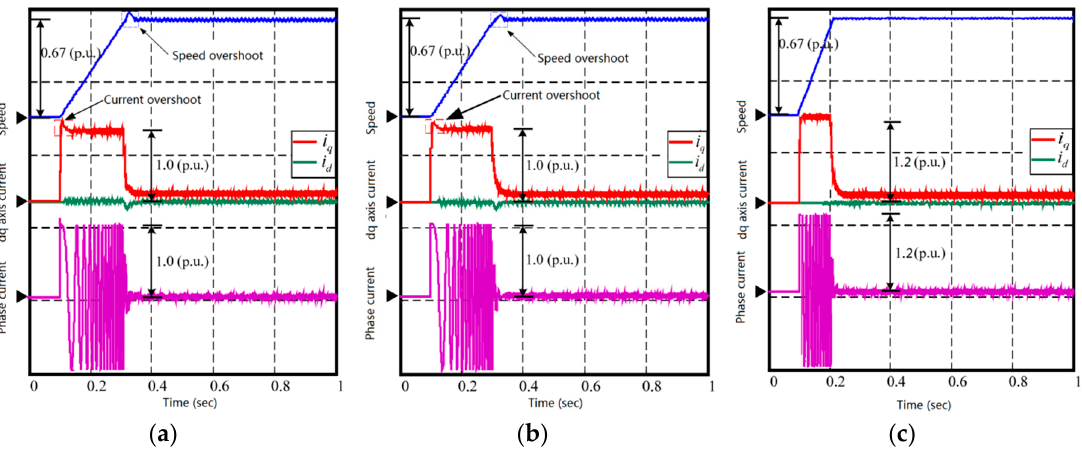
Figure 3. Simulation results of motor starting with appropriate parameters under no-load condition: ( a ) TBC; ( b ) AIBC_FP; ( c ) AIBC_AWPSO.